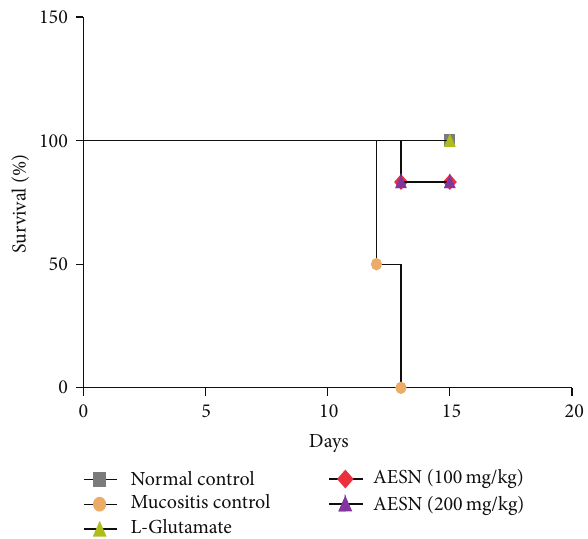
Figure 5: Mortality rate in busulfan and radiation induced oral mucositis. 0% mortality was observed in normal control and L- glutamate groups. However, 100% mortality was seen in mucositis control group on 13th day. Mortality in both the treatment groups was found to be 17% at the end of study